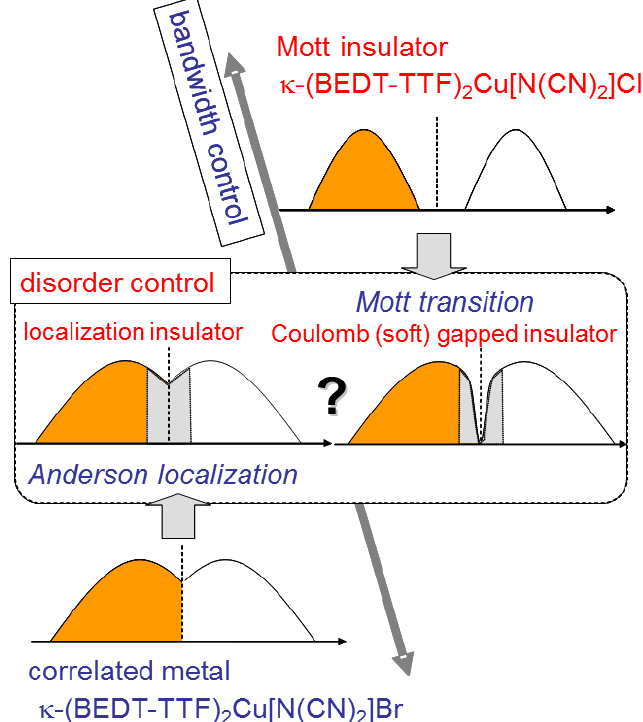
Figure 7. Schematic figure of the density of states at the Fermi level of κ-(BEDT- TTF) Cu[N(CN) ] Y . The electronic state very near the Mott transition with randomness is 2 2 not so clear. A gapless localization state, i.e. , soft Coulomb gapped state, is